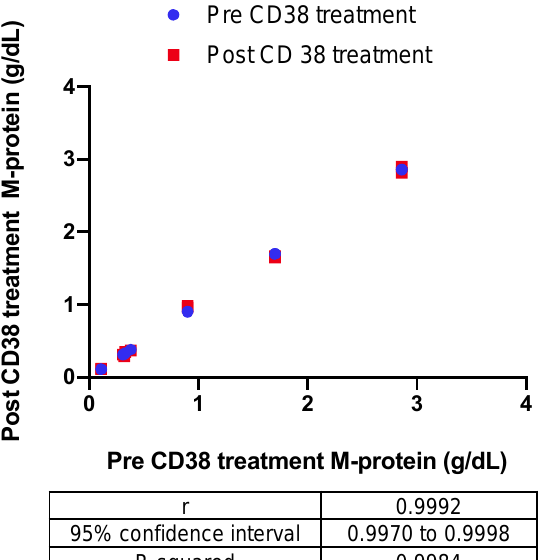
Figure 4. The impact of the recombinant biotinylated CD38-DARA complex on the endogenous M-protein quantification in six patients with a range of endogenous M-protein concentration (0.3–2.9 g/dL) was assessed based on the correlation of the quantitation pre- and post-CD38 treatment (R squared = 0.9984) .